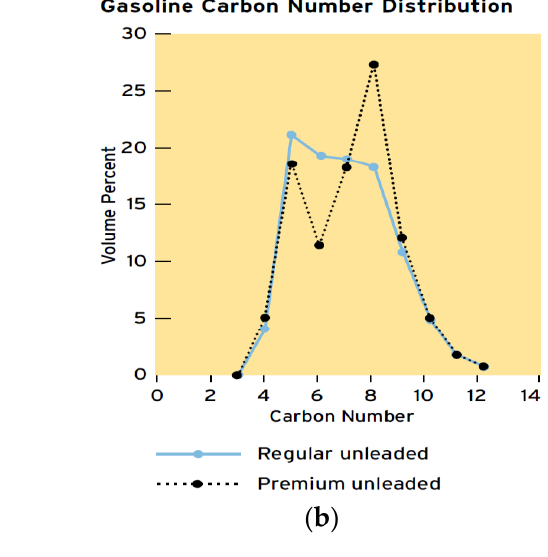
Figure 5. HC content in ( a ) DPO and ( b ) gasoline